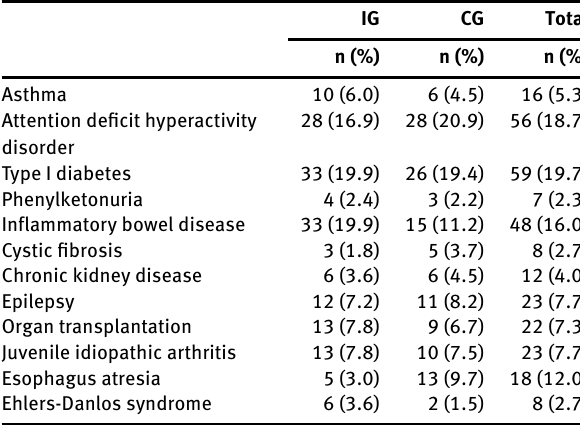
Table 1: Patients’ chronic conditions in the IG and the